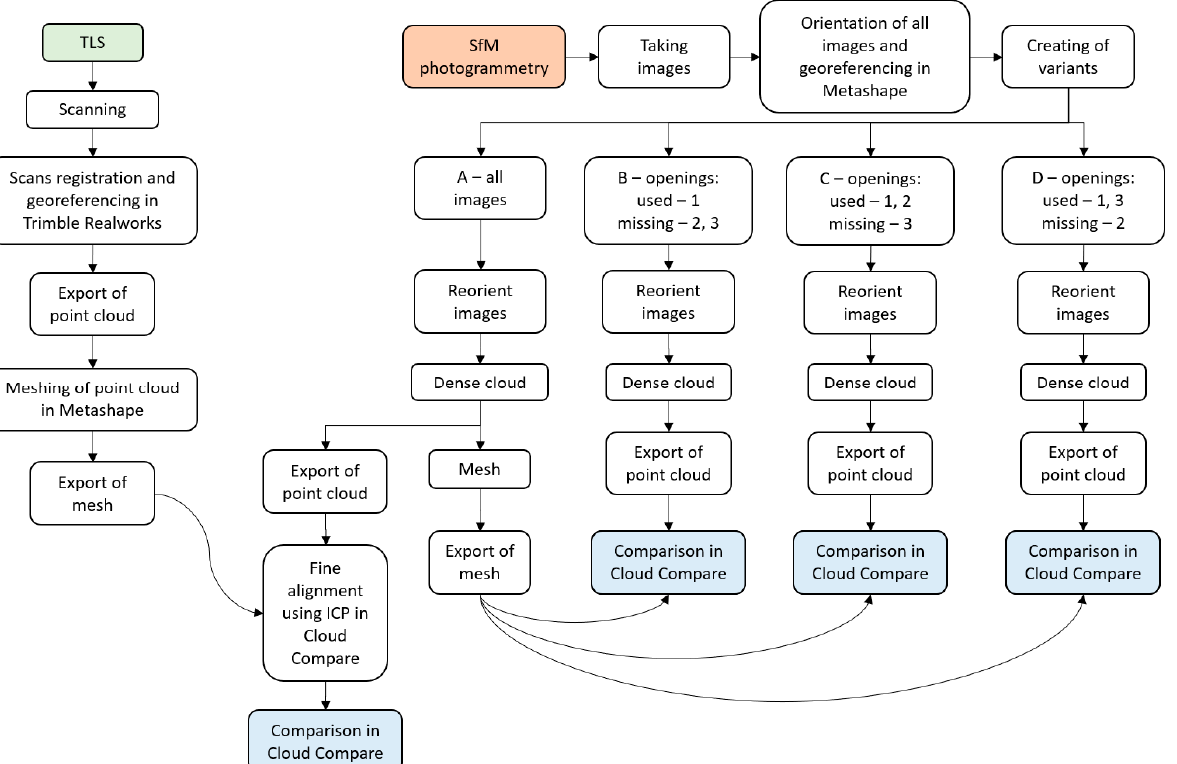
Figure 7. Experiment workflow.